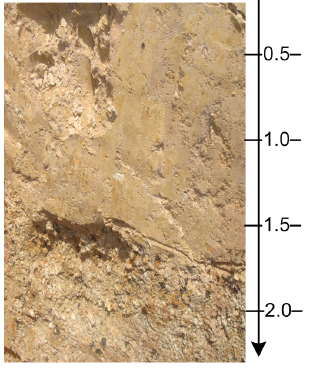
Figure 19. Profile of